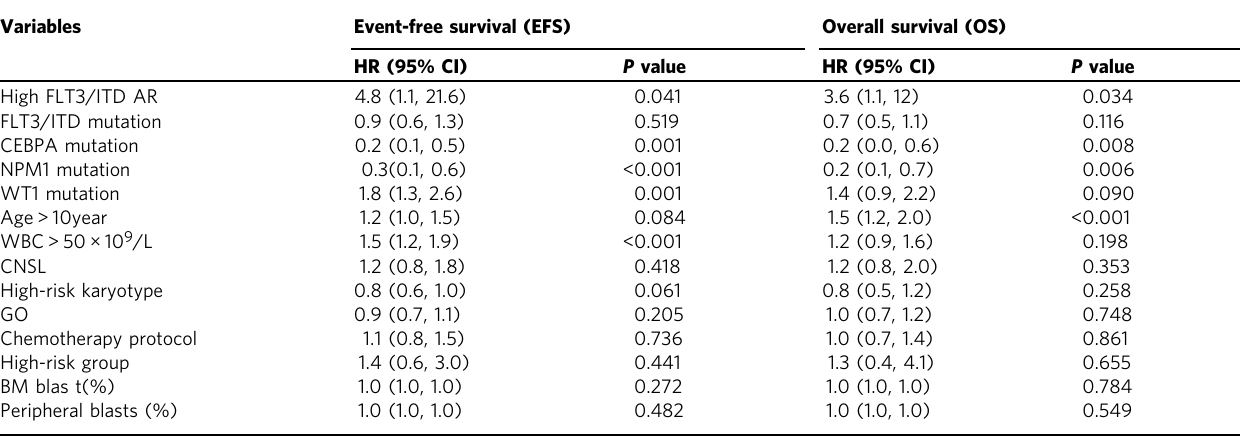
Table 4 Multivariable analysis of prognostic factors for overall and event-free survival from study entry.